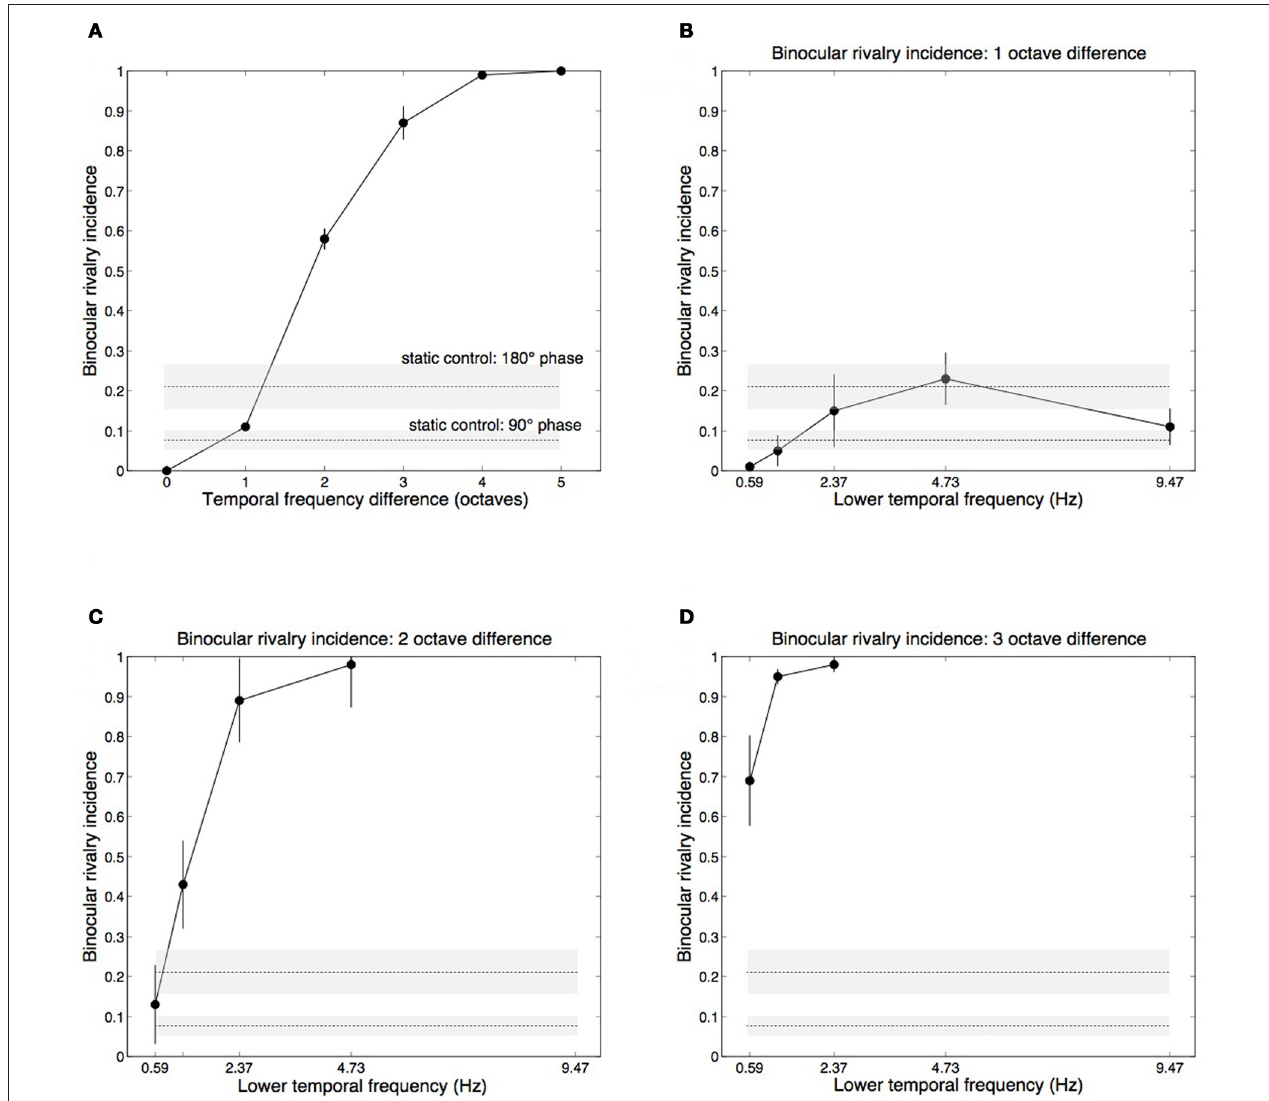
FIGURE 3 | Group mean data with ± 1 standard errors from Experiment 1 showing rivalry incidence for various temporal frequency combinations. Horizontal dashed lines show results from a static control condition (see Methods), with ± 1 standard error shading. (A) Rivalry incidence increases with temporal frequency difference. The data here are means of the diagonals in Table 1 . (B) Rivalry incidence for one-octave temporal frequency